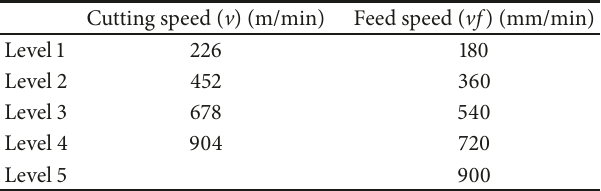
Table 3: Input parameters and their levels for milling of Compacted Graphite Iron (the cutting speed is set to four levels and there are 5 levels for feed